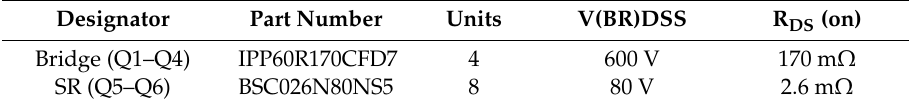
Table 4. Primary side HV MOSFETs and synchronous rectifiers (SRs) MOSFETs in reference design.